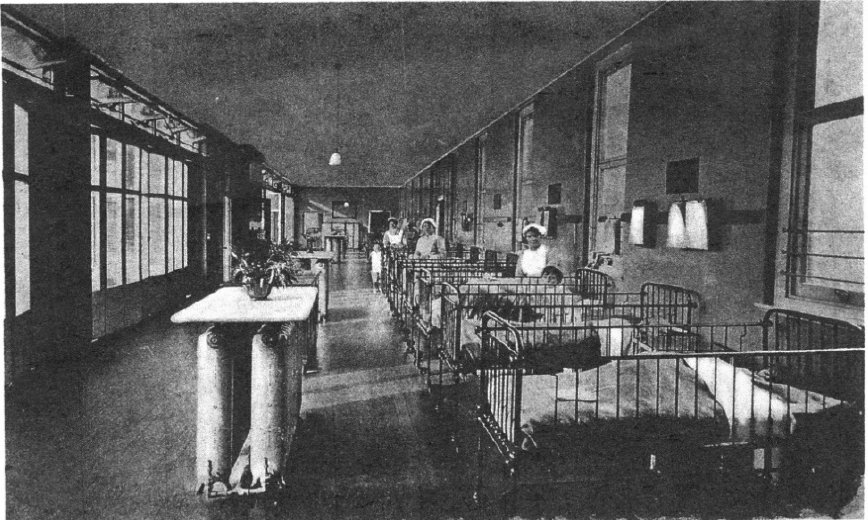
Figure 3. Ward at Birmingham Children’s Hospital circa 1950.